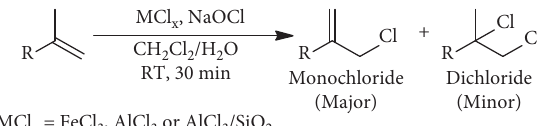
Scheme 1: Allylic chlorination of terminal olefins catalyzed by MCl